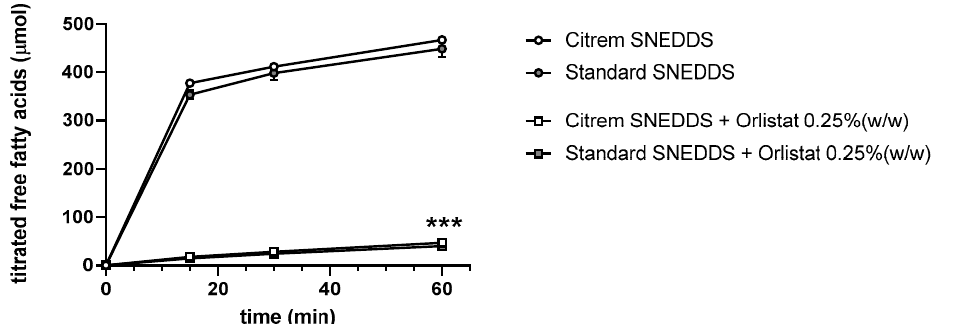
Figure 6. In vitro profile of digestion of SEDDS in fasted-state simulated intestinal fluid presented as the amount of free fatty acids titrated by sodium hydroxide over 60 min. Data are presented as mean ± SD ( n = 3). *** p < 0.001—significant effect of orlistat on SEDDS lipolysis.